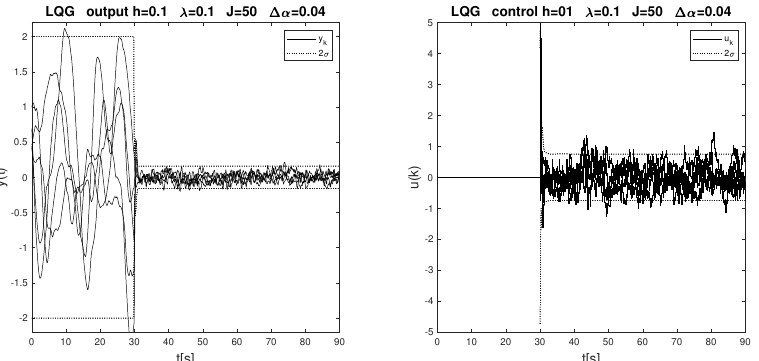
Figure 13. Realization of the output ( left ) and control ( right ) signal for λ = 0.1 and ∆ α = 0.04.